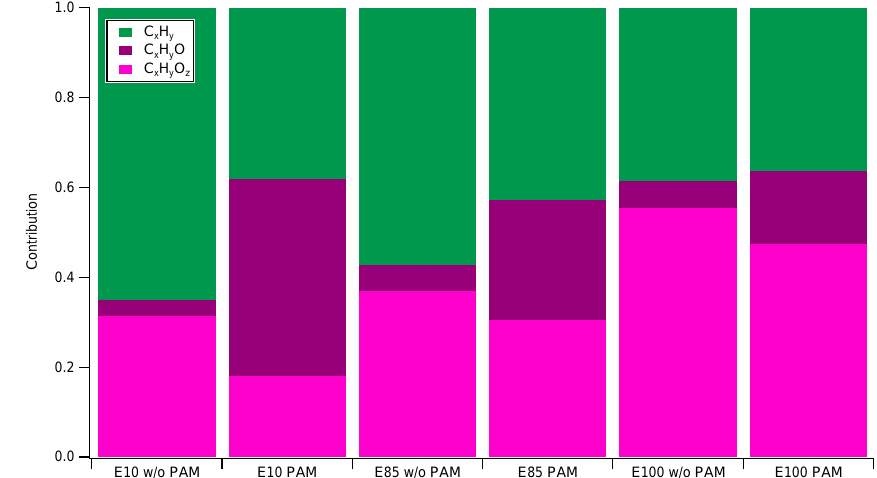
Figure 5. The contribution of the different organic fragments with and without the PAM chamber. CH refers to hydrocarbons (C x H y ) , CHO to fragments with one oxygen atom (C x H y O + z ) and CHO x to compounds containing several oxygen atoms (C x H y O z , z > 1). Table 3. The average concentrations of the main chemical compounds of PM (in µgm − 3 and µgkm − 1 for individual species or mgkm − 1 for total mass) during the NEDC for the primary (w/o PAM) and secondary (PAM) emissions. Cycle Org NO 3 SO